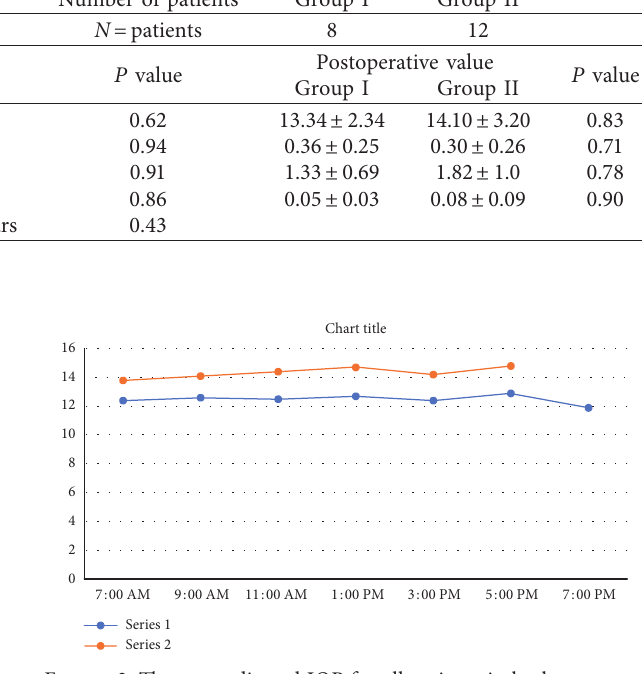
Figure 2: The mean IOP for all patients in both groups at each visit, along with the “ P ” values, demonstrating that there was no sig- nificant difference between the groups at any stage. 172 patients were available for all follow-ups up to one year. 12 patients in Group I and 14 in Group II completed two years of follow-up.